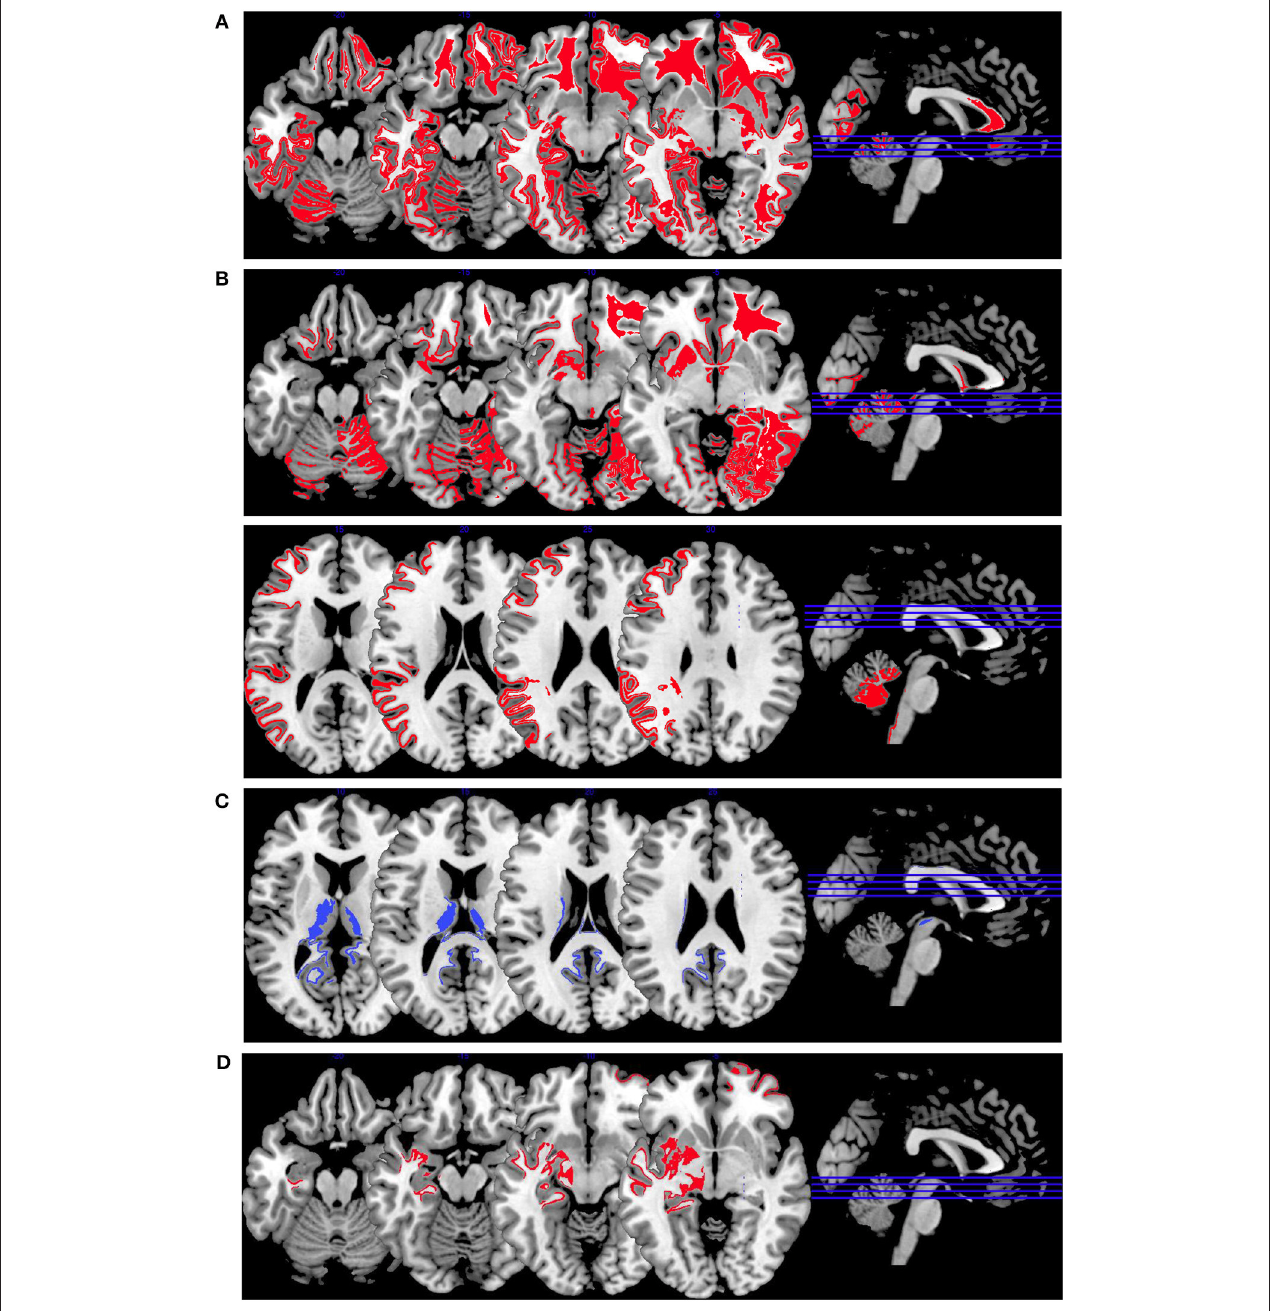
FIGURE 4 | Emotion induction activations. Overview of the working memory brain activation patterns reported by the reviewed studies. Hyperactivations are shown in red, hypoactivations in blue. (A) shows the activation patterns in the group comparison VS vs. NVS with VS > NVS in red (shown slice numbers are 100, 110, 120, 130) in the contrasts shock anticipation phase II (last 21s after threatening with an electric shock) vs. shock anticipation phase I (first 9s after threat) and negative vs. neutral emotional pictures and neutral emotional pictures vs. rest, (B) shows the activation patterns in the group comparison VS vs. HC with VS > HC in red (shown slice numbers are 100, 110, 120, 130) in the contrasts shock anticipation vs. safe condition and in negative vs. neutral emotional pictures contrast and neutral emotional pictures vs. rest, (C) shows the activation patterns in the group comparison NVS vs. HC with NVS > HC in red (shown slice numbers are 170, 180, 190, 200) in the contrast negative vs. neutral emotional pictures and NVS < HC in blue (shown slice numbers are 160, 170, 180, 190) in the contrast positive vs. neutral emotional pictures, (D) shows the activation patterns in the group comparison NVS high vs. low aggression with NVS high > NVS low in red (shown slice numbers are 100, 110, 120, 130) in the contrast of hearing emotional words (positive and negative ones) vs. rest.